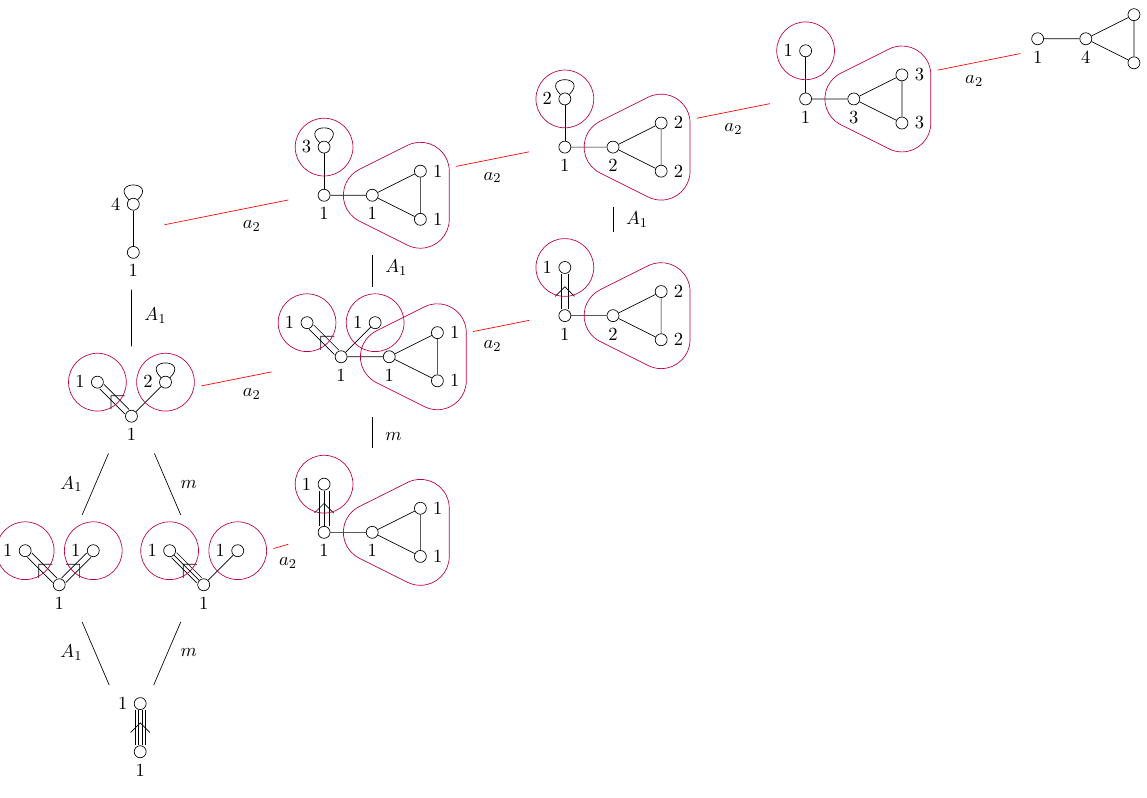
Figure 7. Quiver subtraction algorithm for the moduli space of 4 SU(3) instantons. Decoration is only added where